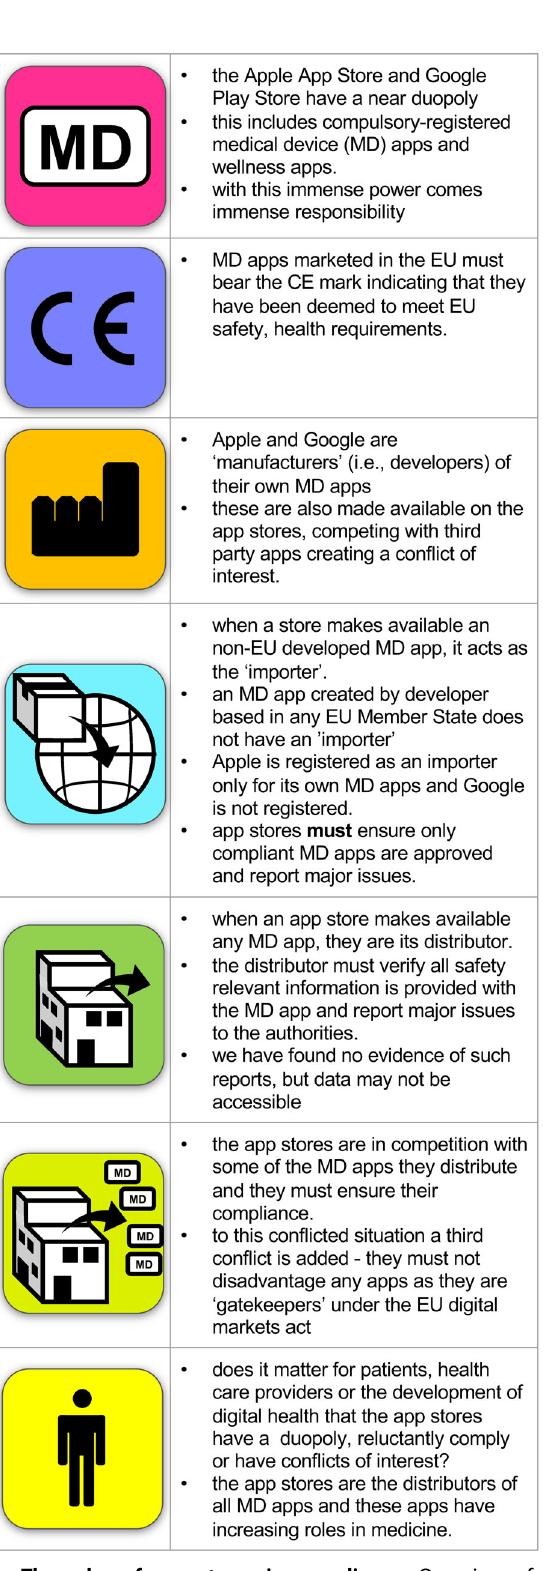
Fig. 3 The roles of app stores in compliance. Overview of the challenges for app stores in balancing their medical device compliance role, their role as MD app developers and their obligations as gatekeepers in the EU digital market. Similar app store responsibilities for wellness apps may be introduced under the proposed legislation. MD Medical Devices, CE Conformité